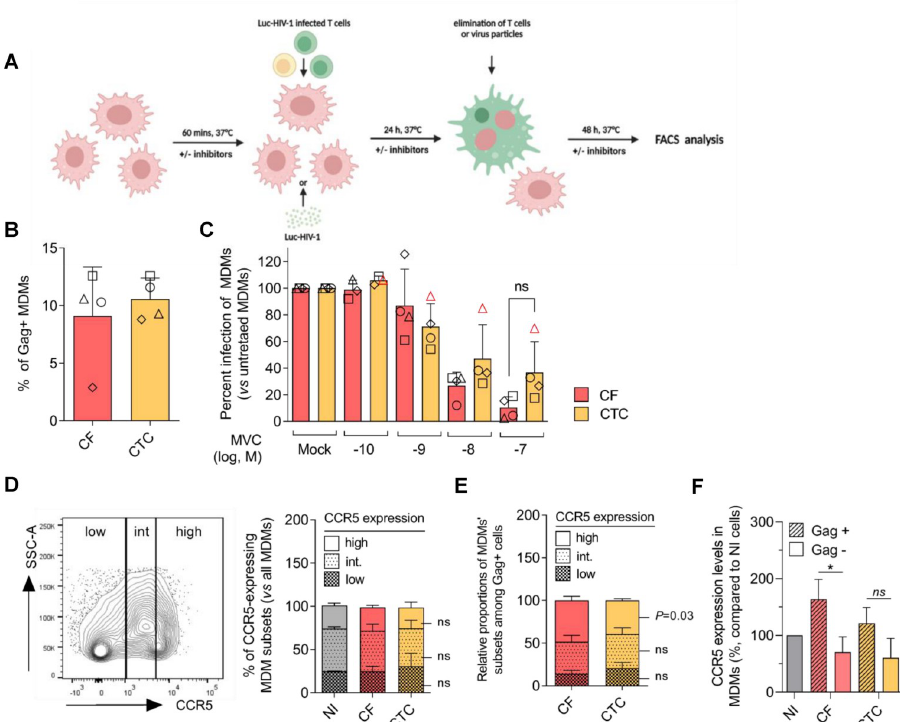
Fig 5. Increased efficiency of CCR5 use in HIV-1 transfer between infected T cells and MDMs. A) Experimental scheme of experiments. B) The experiments analyzing CCR5 dependence were performed with similar proportion of infected MDMs (Gag+ MDMs) exposed to cell-free JR-FL Env-pseudotyped viruses or Jurkat cells infected with the same viruses. C) Dose-dependent inhibition by maraviroc (MVC) of MDM infection through cell-to-cell viral transfer (CTC) or by cell-free viral particles (CF). MDMs were incubated at 37˚C for 60 min with the indicated doses of MVC, then exposed for 24 h to infected Jurkat cells or viral particles (in the presence of the same doses of MVC), washed and incubated for further 48 h à 37˚C (still with MVC). Infectivity was then determined by flow cytometry by quantifying the amount of Gag+ MDMs. Results represent means ± SD of 4 independent experiments, expressed as percent infectivity relative to infectivity determined in the absence of MVC (100%). D) The left panel represents the gating strategy of MDMs expressing low, intermediate or high levels of CCR5, after CTC or CF infection in the absence of MVC, as detailed above. A representative flow cytometry plot of cell side scatter as a function of CCR5 expression level revealed with a PE-Vio 770-conjugated anti-CCR5 mAb is shown. Data were acquired using a BD LSRII flow cytometer. Right panel: Relative proportions of MDM subsets expressing low, intermediate or high levels of CCR5 among all MDMs exposed, or not (NI), to infected Jurkat cells (CTC) or to cell-free viruses (CF). E) Relative proportion of MDMs expressing low, intermediate or high levels of CCR5 among total Gag+ MDMs after cell-to-cell viral transfer (CTC) or cell-free (CF) infection. Results are expressed as percent of total Gag+ cells. F) CCR5 expression levels at the surface of Gag+ or Gag- MDMs after CTC or CF infection, compared to untreated MDMs (NI). Receptor expression levels were determined by FACS analysis, measuring the geometric mean fluorescence intensity of PE-Vio770-conjugated anti-human CCR5 bound to the different MDM populations. Statistics: Mann-Whitney U-test: � , P < 0.05; ns: not significant.